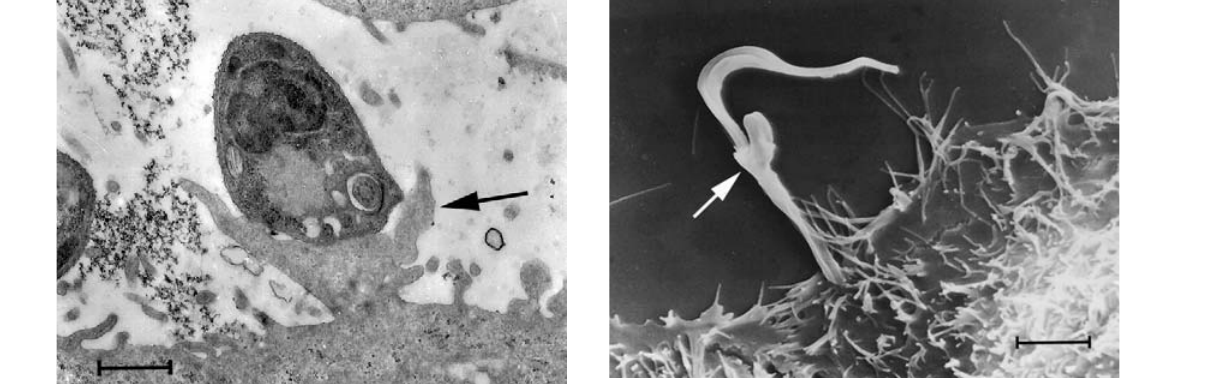
Fig. 1 – Formation of a cup-like pedestal (arrow) upon invasion of HeLa cells by extracellular amastigotes. Transmission elec- tron microscopy of HeLa cells recently infected with G strain extracellular amastigotes. Bar: 500 µ m.